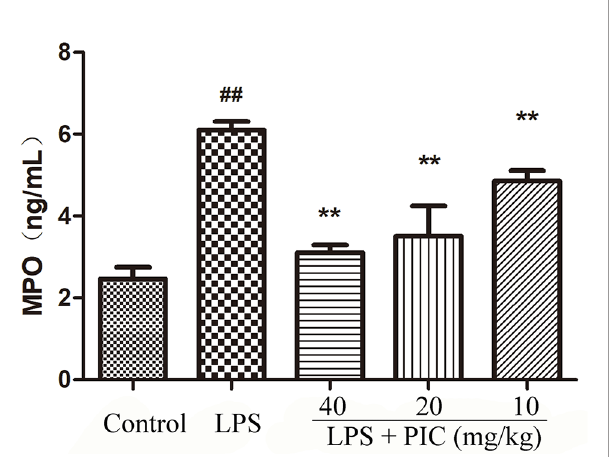
FIGURE 3 | Myeloperoxidase (MPO) activity. The MPO activity in lung tissues were measured by the MPO ELISA kit. ## p < 0.01 is signi fi cantly different from the control group; ** p < 0.01 are signi fi cantly different from the lipopolysaccharide (LPS)